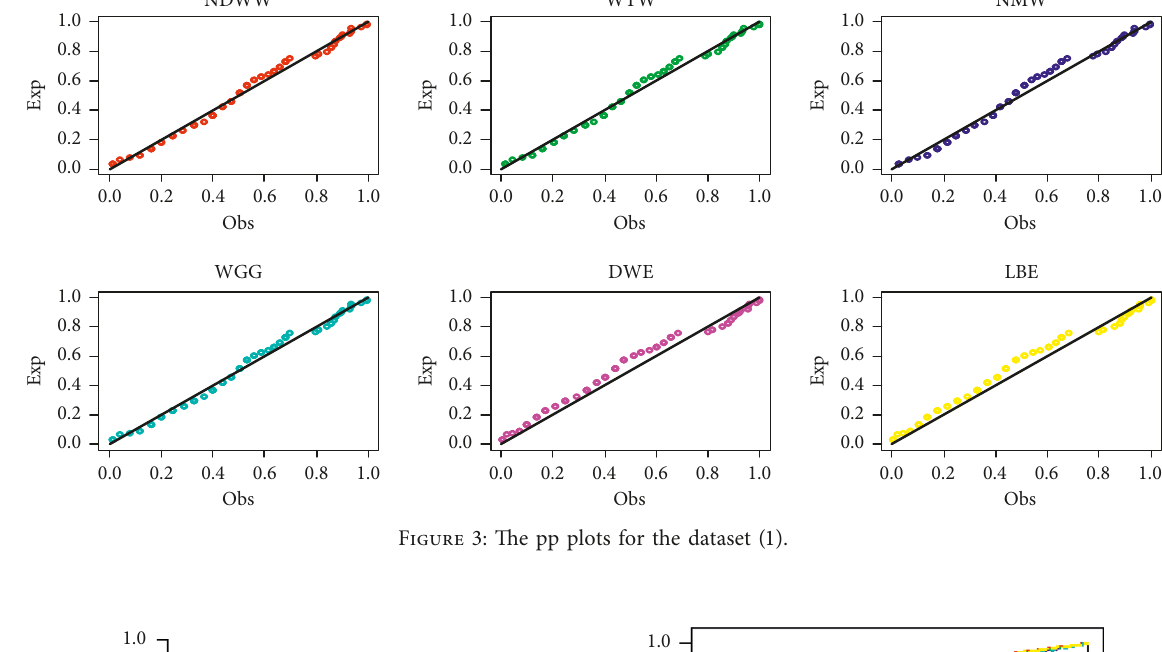
Figure 3: The pp plots for the dataset